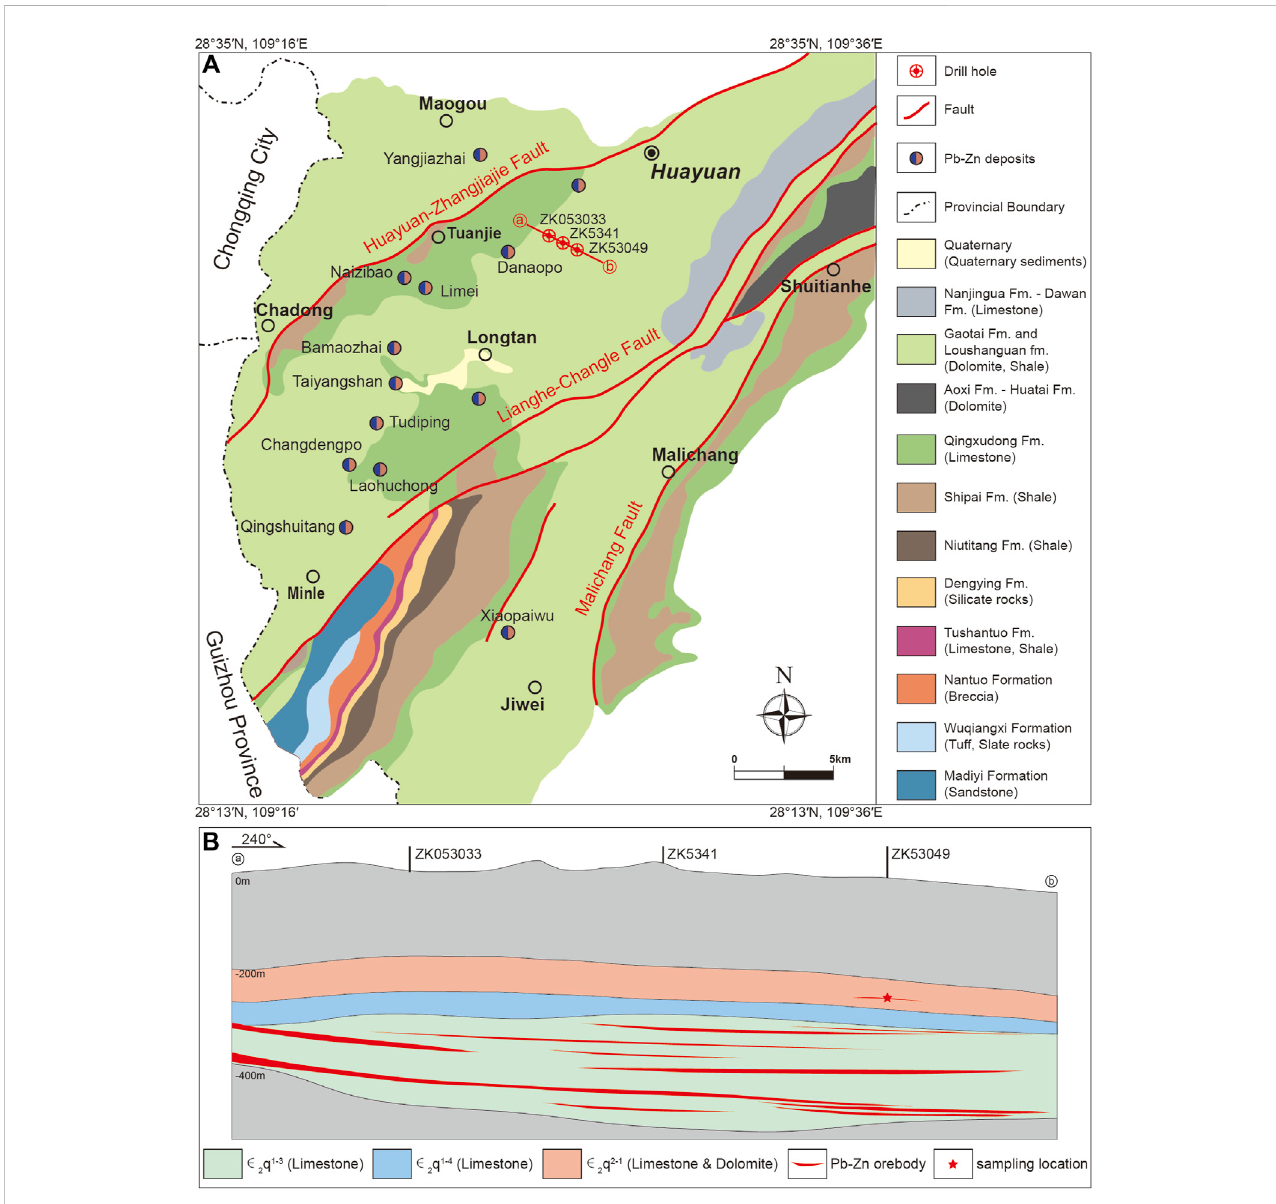
FIGURE 2 (A) Geological map of the Huayuan Pb-Zn ore fi eld (modi fi ed after Duan, 2014). (B) Geological pro fi le of the Danaopo Exploration Line No. 53.